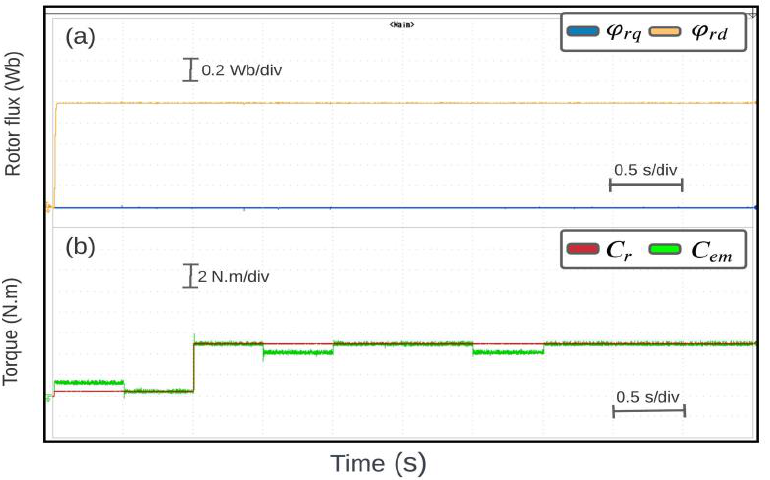
Figure 13. OeW-5PIM performance during low-speed reverse ( a ) d-q rotor flux responses; ( b ) devel- oped torque.